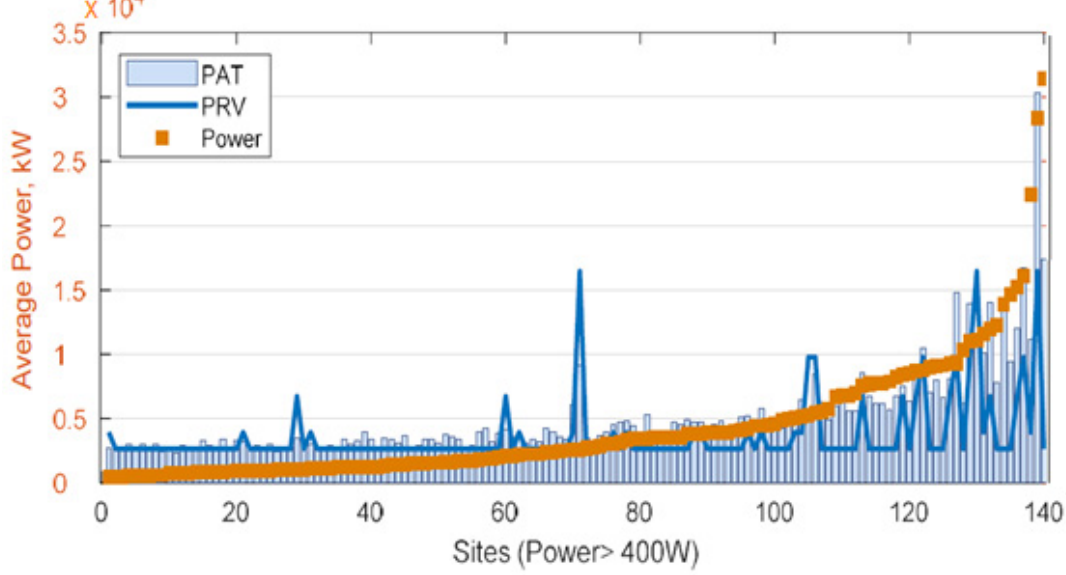
Figure 6. Micro-hydro average generated power by PATs (red) and comparison between PAT vs. PRV total cost (blue).